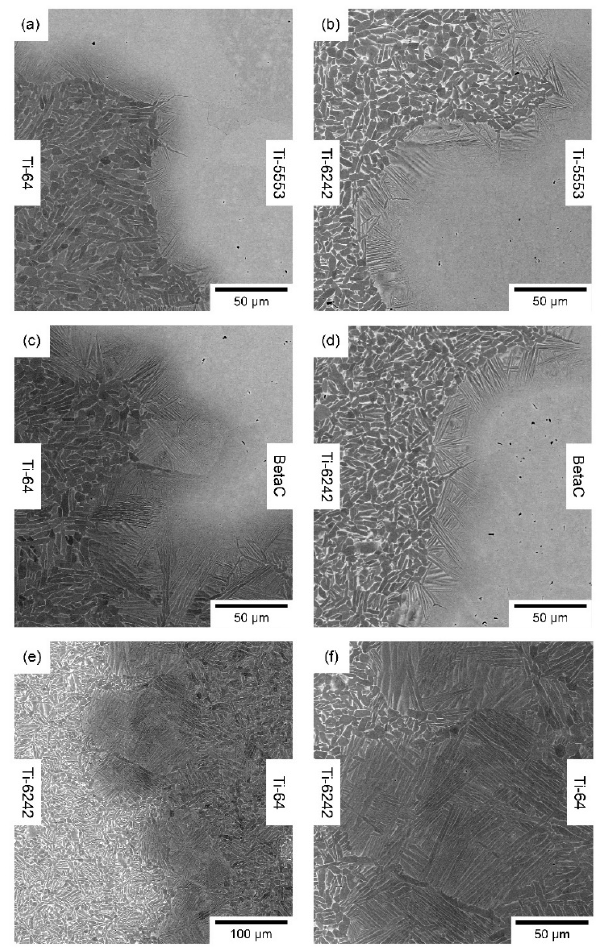
Figure 4. Backscatter electron micrographs of a range of titanium alloy diffusion bond pairings from the Mul Ti ‐ FAST billet, processed at 970 °C and for a dwell time of 25 min. ( a ) Ti ‐ 64/Ti ‐ 5553, ( b ) Ti ‐ from the Mul Ti-FAST billet, processed at 970 ◦ C and for a dwell time of 25 min. ( a ) Ti-64/Ti-5553, 6242/Ti ‐ 5553, ( c ) Ti ‐ 64/Beta C, ( d ) Ti ‐ 6242/Beta C, ( e ) Ti ‐ 6242/Ti ‐ 64 at low magnification and ( f ) Ti ‐ ( b ) Ti-6242/Ti-5553, ( c ) Ti-64/Beta C, ( d ) Ti-6242/Beta C, ( e ) Ti-6242/Ti-64 at low magnification and 6242/Ti ‐ 64 at high magnification. ( f ) Ti-6242/Ti-64 at high